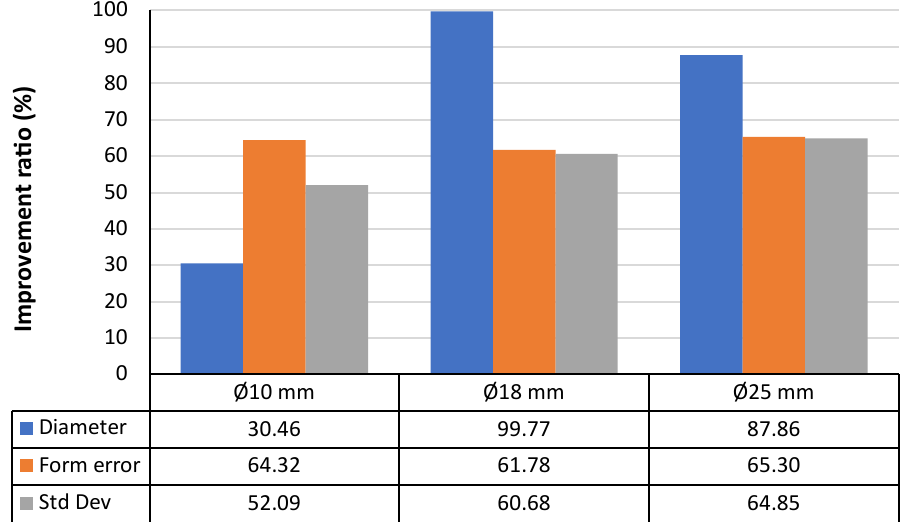
Figure 12. Improvement ratio in the noncontact measurement for the three parameters studied and the three diameters considered after the sandblasting process.